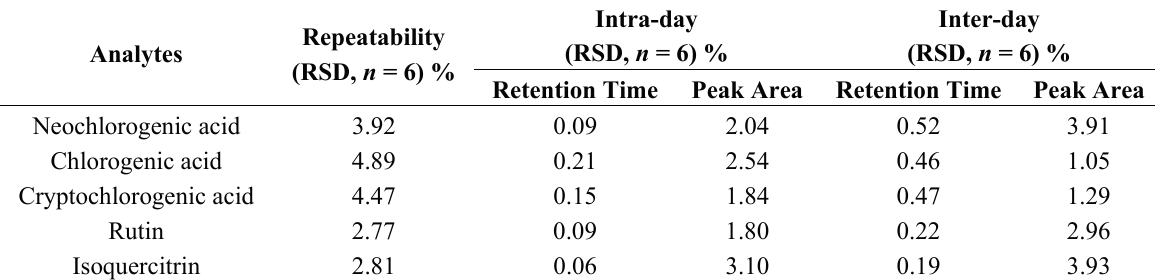
Table 2. Repeatability and precision of the investigated analytes.